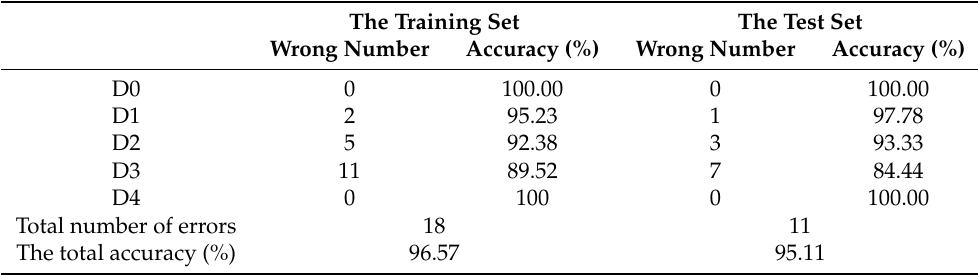
Table 7. Comparison of defect classification